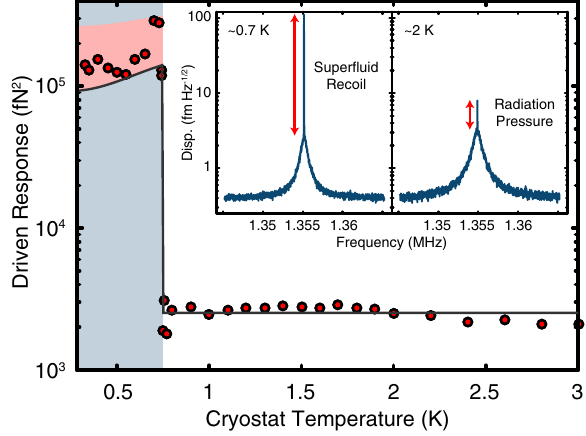
FIG. 4. Driven response of the flexural mode as the cryostat is cooled (red points), showing a step increase in response at the superfluid transition temperature. Black line represents a theo- retical fit to the data. The gray shaded area indicates that a superfluid layer has formed on the microtoroid surface. The pink shaded area represents the theoretical force if T is up to 1 K evap higher than the mode temperature. Inset: Displacement spectrum of the flexural mode at 0.7 and 2 K with a coherent drive applied via optical amplitude modulation. The response to coherent drive is shown to increase with the presence of superfluid